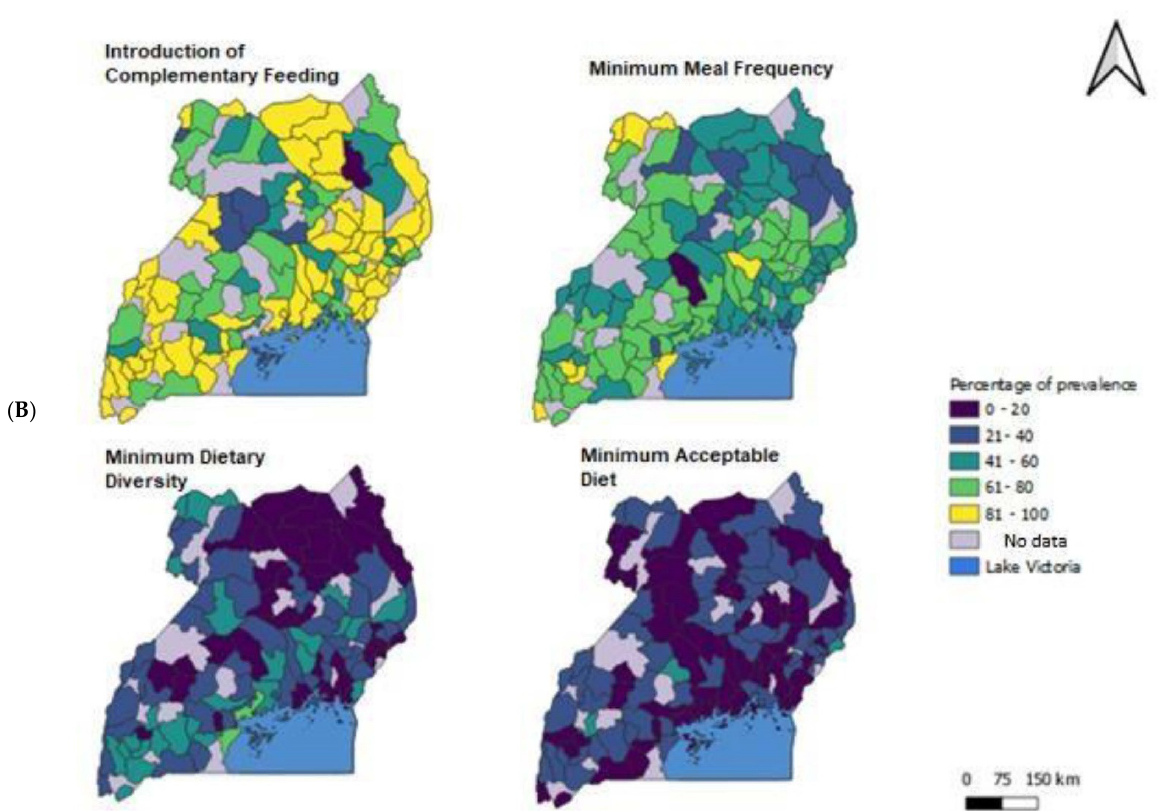
Figure 2. ( A ) Composite map describing the complementary feeding indicators (MMF, MDD & MAD) in Uganda. Group 1, in green, represents those falling into the top quartile of districts (higher %) for 3 or more indicators (relatively high achievers); group 2, in red, represents those falling into the bottom quartile of districts (lowest %) for 3 or more indicators (relatively low achievers); Group 3, in blue, represents all other districts (mixed achievement). ( B ) Geographical distribution of children meeting each complementary feeding indicator in Uganda indicated with different colours (yellow = 81–100%; light green = 61–80%; dark green = 41–60%; blue = 21–40%; purple = 0–20%). Maps created through the QGIS program.